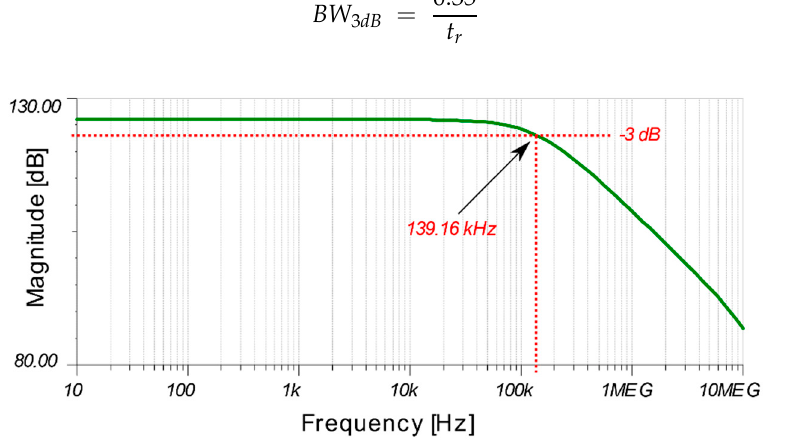
Figure 4. Bode plot of TIA receiver circuit.